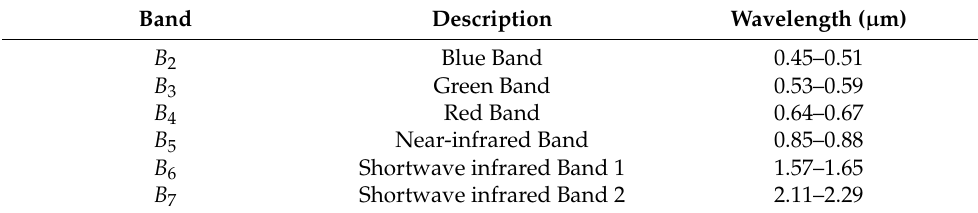
Table 1. Bands of Landsat 8 image used in this